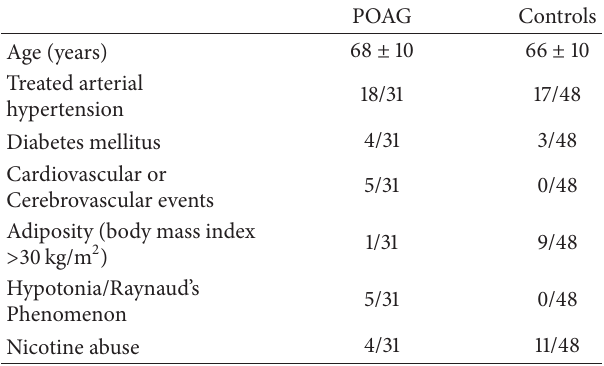
Table 3: Clinical data of patients with POAG and control subjects. Table 4: Analysis methods and amount of significant parameter ( 𝑝 < 0.05 ) for controls versus POAG for each time